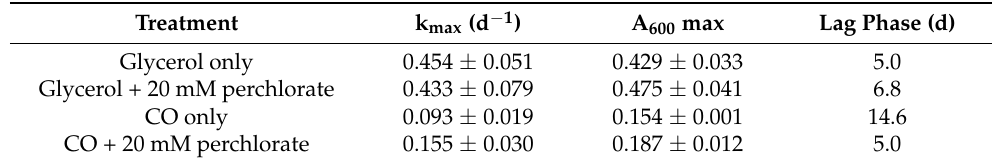
Table 1. Maximum growth rate constants (k max , d − 1 ), maximum cell densities (A 600 max), and lag phases (d) for M . glycerini DSM 11254 T incubated under various conditions as indicated. Values are means of triplicate determinations ± 1 standard error for k max and A 600 max; lag phases are means of triplicates that were the same for each replicate. Treatment k max (d − 1 ) A 600 max Lag Phase (d) Glycerol only 0.454 ± 0.051 0.429 ± 0.033 5.0 Glycerol + 20 mM perchlorate 0.433 ± 0.079 0.475 ± 0.041 6.8 CO only 0.093 ± 0.019 0.154 ± 0.001 14.6 CO + 20 mM perchlorate 0.155 ± 0.030 0.187 ±